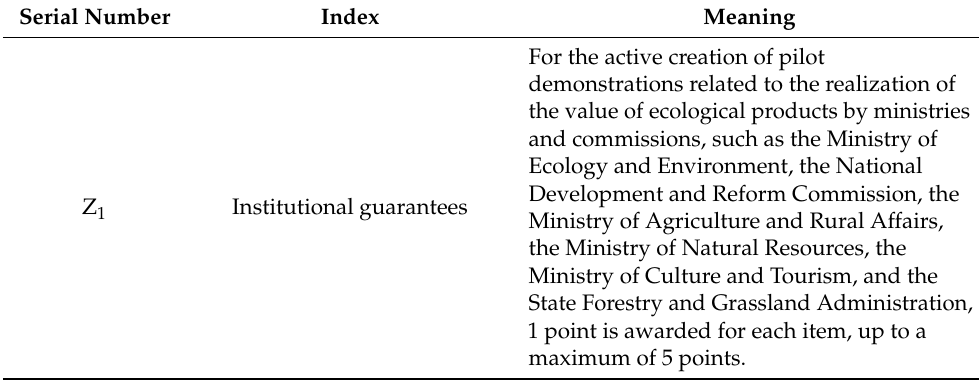
Table 5. Indicators and index interpretation of the guarantee mechanism for the EPV realiza- tion